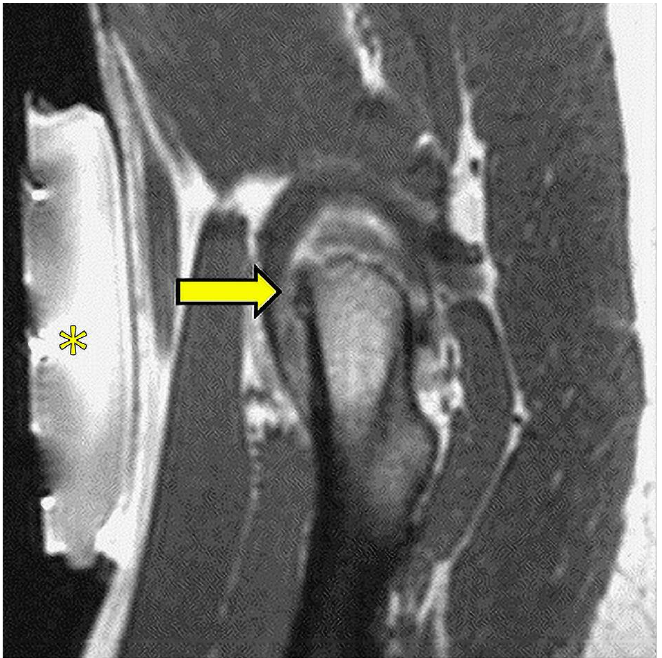
Figure 10. Image from a MRgFUS treatment of a small osteoid osteoma of the femoral neck (arrow); the transducer (*) lies on the patient’s skin and produces and focuses the ultrasound beam. Several studies have evaluated the application of HIFU — primarily through ultra- sound guidance but also through MRI guidance — in pancreatic cancers either for pallia- tive treatment or combined with other therapies (chemotherapy, radiotherapy, surgery) thors report a variable tumor response (in terms of devascularization and/or tumor size reduction), while a common endpoint across all studies is the significant effect of HIFU treatment in the palliation of pain [132]. 5. New Frontiers The interest in artificial intelligence (AI) in radiology is fast-growing not only in di- agnostic imaging but also in interventional radiology [133]. Deep learning algorithms showed promising results in diagnostic imaging in helping the most effective customiza- tion of treatments and triage of resources [134] and can also be applied in IO to predict the efficacy of therapy, improving patients ’ selection. AI can be applied in different phases of IO: for the outcome prediction and patients’ selections and as a supporting tool for clinical and imaging decisions, for a pre-procedural accurate imaging assessment and image quality improvement, and as intra-procedural assistance (e.g., selection of the most appropriate materials). Precision medicine relies on the concept of better patient selection. AI decision-support systems may help tailor treat- ment decisions based on imaging phenotypes, yielding better clinical results [135]. Inter- ventional radiologists often rely on multidisciplinary boards for oncological treatment strategies. These board discussions perform multiparametric risk-stratification, integrat- ing the patients ’ data before treatment is advised; different AI applications replicate and outperform these discussions by predicting the outcomes and/or the benefits of treatment before performing it [136].